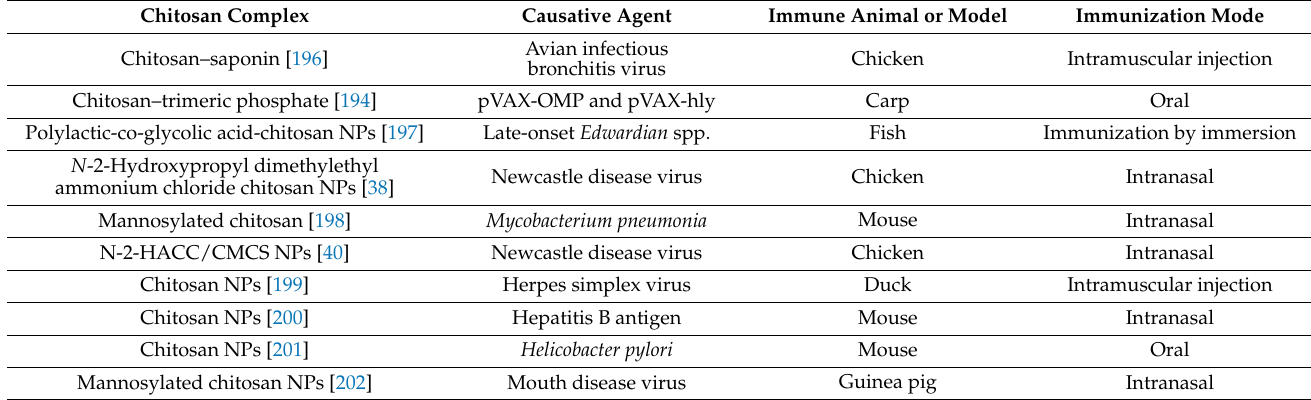
Table 7. Application of chitosan-based complexes in DNA